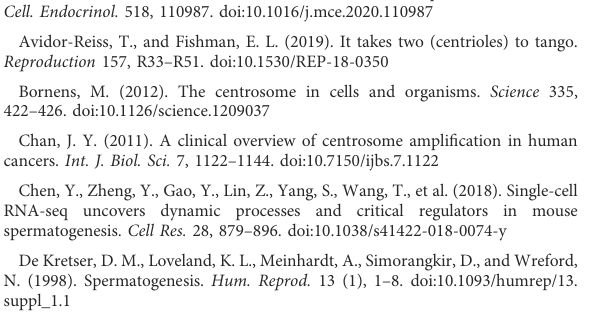
SUPPLEMENTARY FIGURE S1 Testicular high expression of Cep72 is mainly expressed in male germ cells ofmice and humans. (A) RT-PCR results of Cep72 expressionlevels in various tissues in mice. H 2 O was used as a negative control. ACTB was performed as an internal control. (B) GST-Cep72 (333-613aa)-8xHis antigen (66.5kD)was stained by Coomassie-blue(A lane, washing buffer A; B lane, washing buffer B; and E lane, elution buffer). (C) Histogram showing the expression pro fi le of Cep72 in mouse spermatogenic cells (GSE107644). (D) Histogram showing the expression pro fi le of Cep72 in human spermatogenic cells (GSE106487). SUPPLEMENTARY FIGURE S2 De fi ciency of Cep72 does not affect fertility of female mice or global testicular transcript levels in male mice. (A) Fertility statistics of female Cep72 KO mice. Data were provided as mean ± SEM, n = 4, ns: no signi fi cant difference. (B) H&E staining displaying the normal follicular development of 6-month-old female Cep72 KO mice. (C) Scatter plot indicating the transcript levels of Cep72 KO and WT mice. Differentially expressed genes (DEGs) with a log2 fold change (fold change ≥ 1, padj value ≤ 0.05) were shown in yellow plots. (D) Heatmap representing DEGs between Cep72 KO and WT